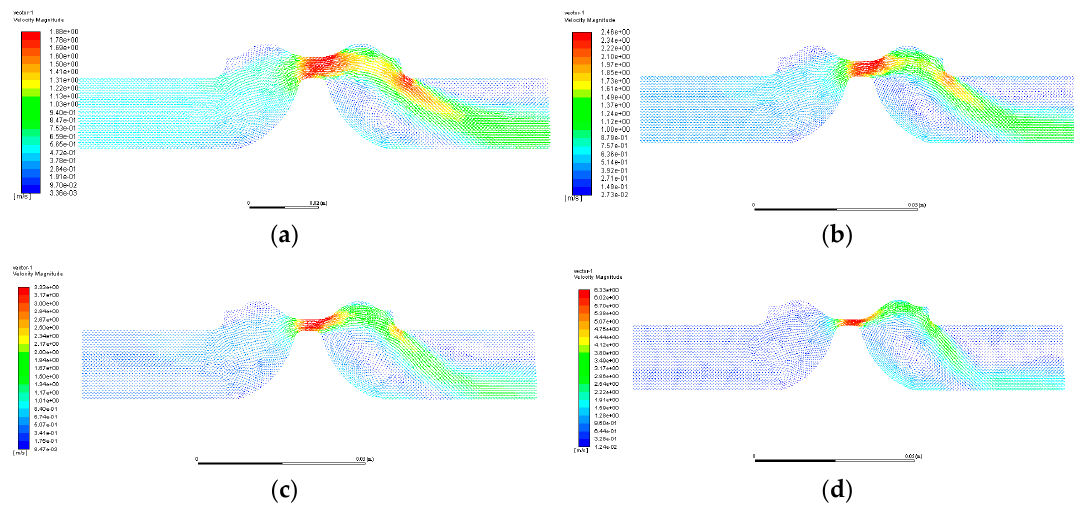
Figure 9. Cloud Map Display of Velocity Field at Different Openings shows that as the valve opening decreases, the velocity gradient increases. ( a ) for 40% opening; ( b ) for 30% opening; ( c ) for 20% opening; ( d ) for 10% opening.